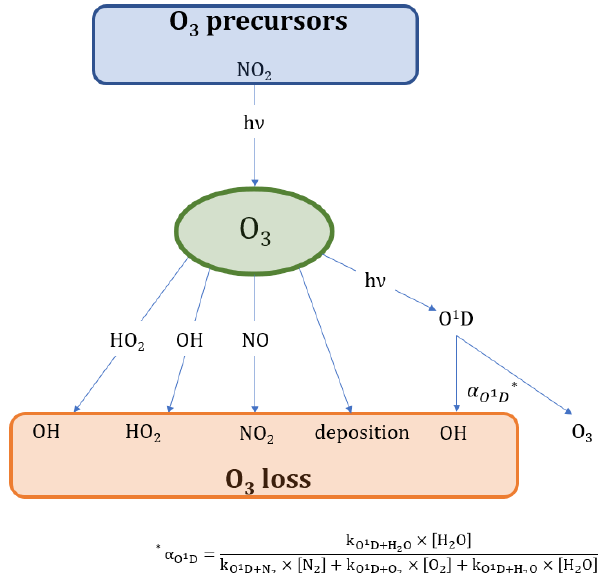
Figure 2. Overview of the chemical and photolytic reactions which lead to O 3 production and